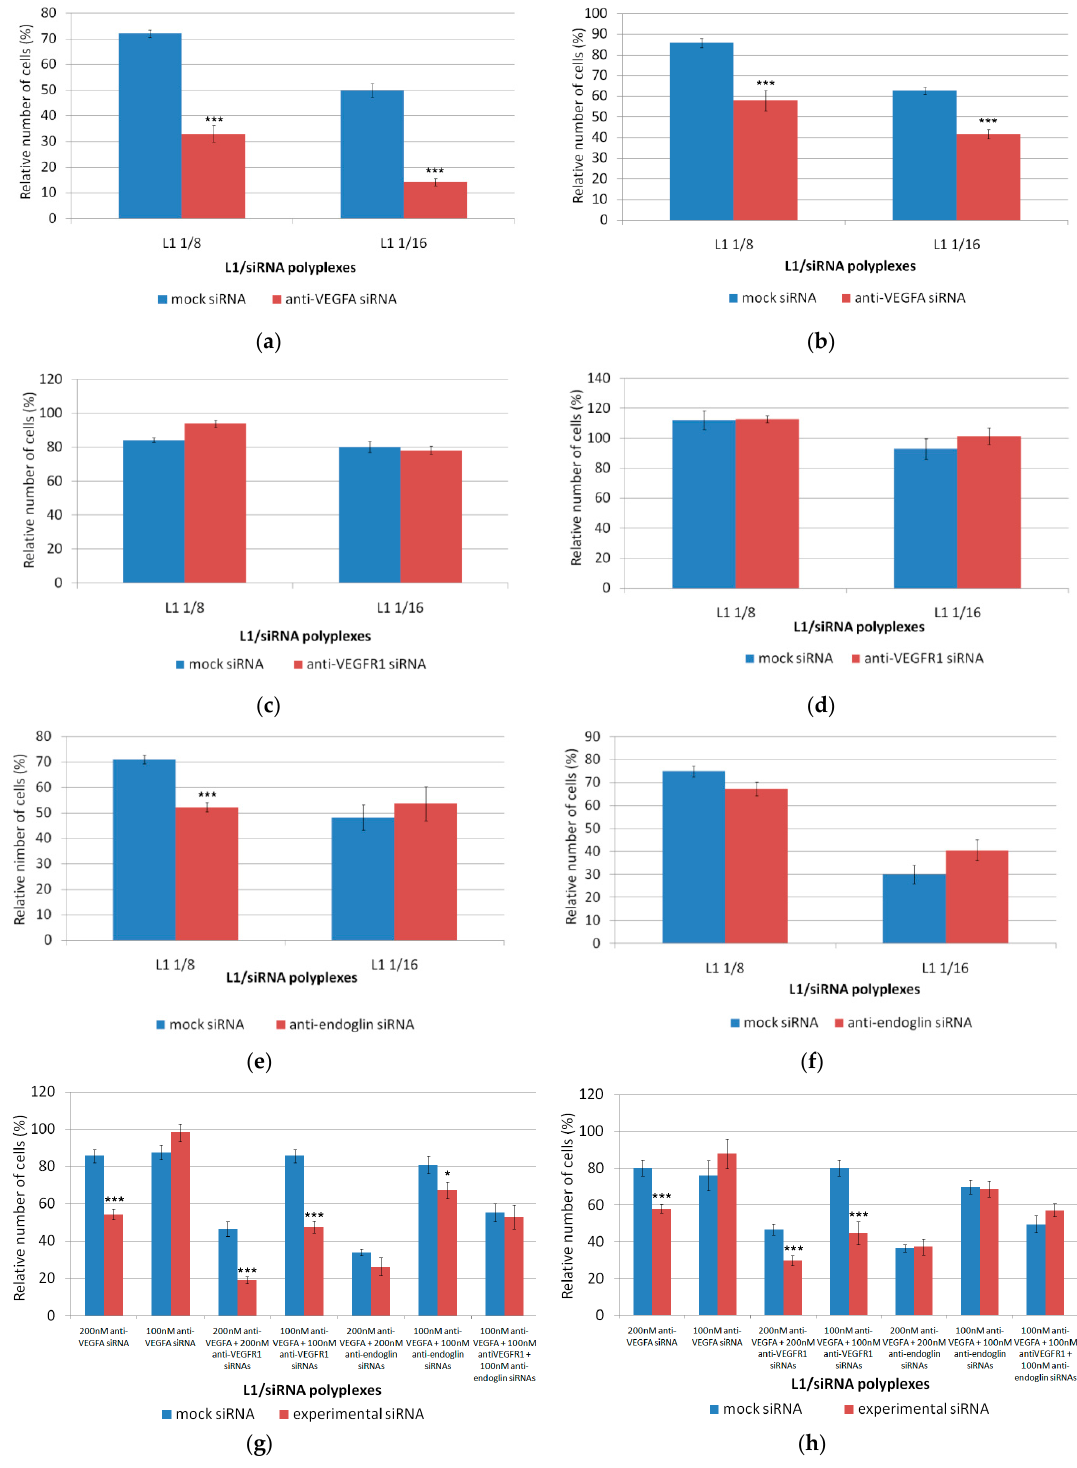
Figure 6. Number of EA.Hy926 cells after treatment with L1 / anti-VEGFA siRNA ( a , b ), L1 / anti-VEGFR1 siRNA ( c , d ), L1 / anti-endoglin siRNA ( e , f ), and L1 / mixed siRNA complexes ( g , h ) analyzed using Alamar blue assay ( a , c , e , g ) and by crystal violet assay ( b , d , f , h ); * p < 0.05, *** p < 0.001 when compared with cells treated using mock siRNA.